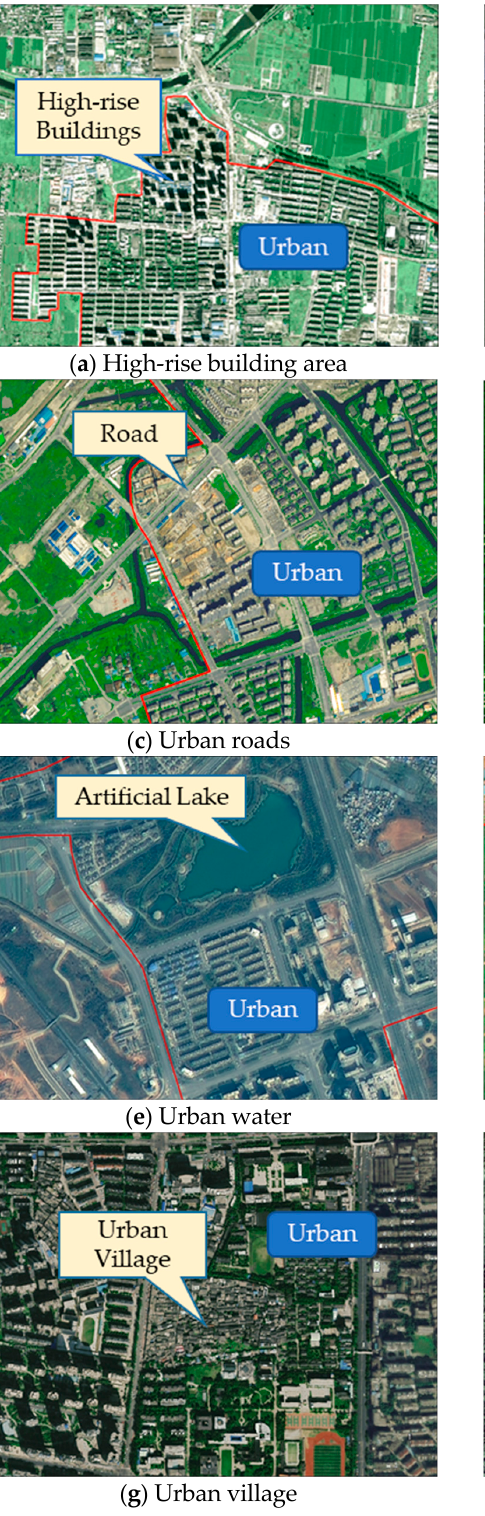
Figure 3. Examples of urban feature interpretation symbol: ( a ) an example of high-rise buildings in urban areas; ( b ) an example of low-rise buildings in urban area; ( c ) an example of roads in urban area; ( d ) an example of green space near the edge of urban area; ( e ) an example of urban water, namely an artificial lake, in urban area; ( f ) an example of structure, namely a stadium, in urban area; ( g ) an example of urban village; ( h ) an example of enclave, namely an industrial and mining area, of urban area.